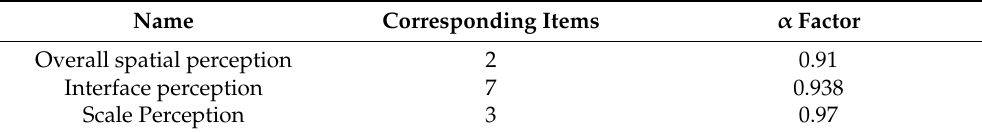
Table 8. Cronbach reliability analysis.